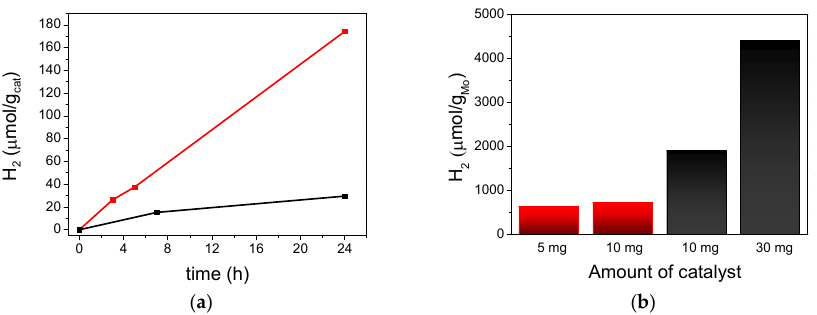
Figure 7. Amount of H 2 evolved during the photocatalytic experiment in water/methanol in the vapor phase. ( a ) represents the reaction yields (μmol/g cat ) of (TBA) 2 Mo 6 I i8 @GO (black line) and (TBA) 2 [Mo 6 I i 8 (O 2 CCH 3 ) a 6 ] (red line) catalysts (10 mg); ( b ) represents the reaction yields (μmol/g Mo ) of (TBA) 2 Mo 6 I i8 @GO (in black) and (TBA) 2 [Mo 6 I i8 (O 2 CCH 3 ) a6 ] (in red) in different weights after 24 h of radiation.